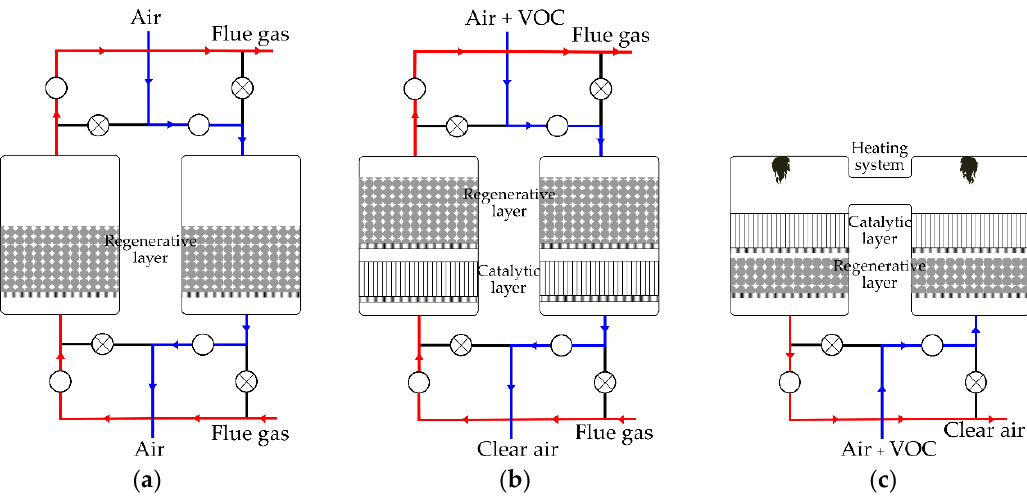
Figure 1. Some types of geometry of storage materials [1].